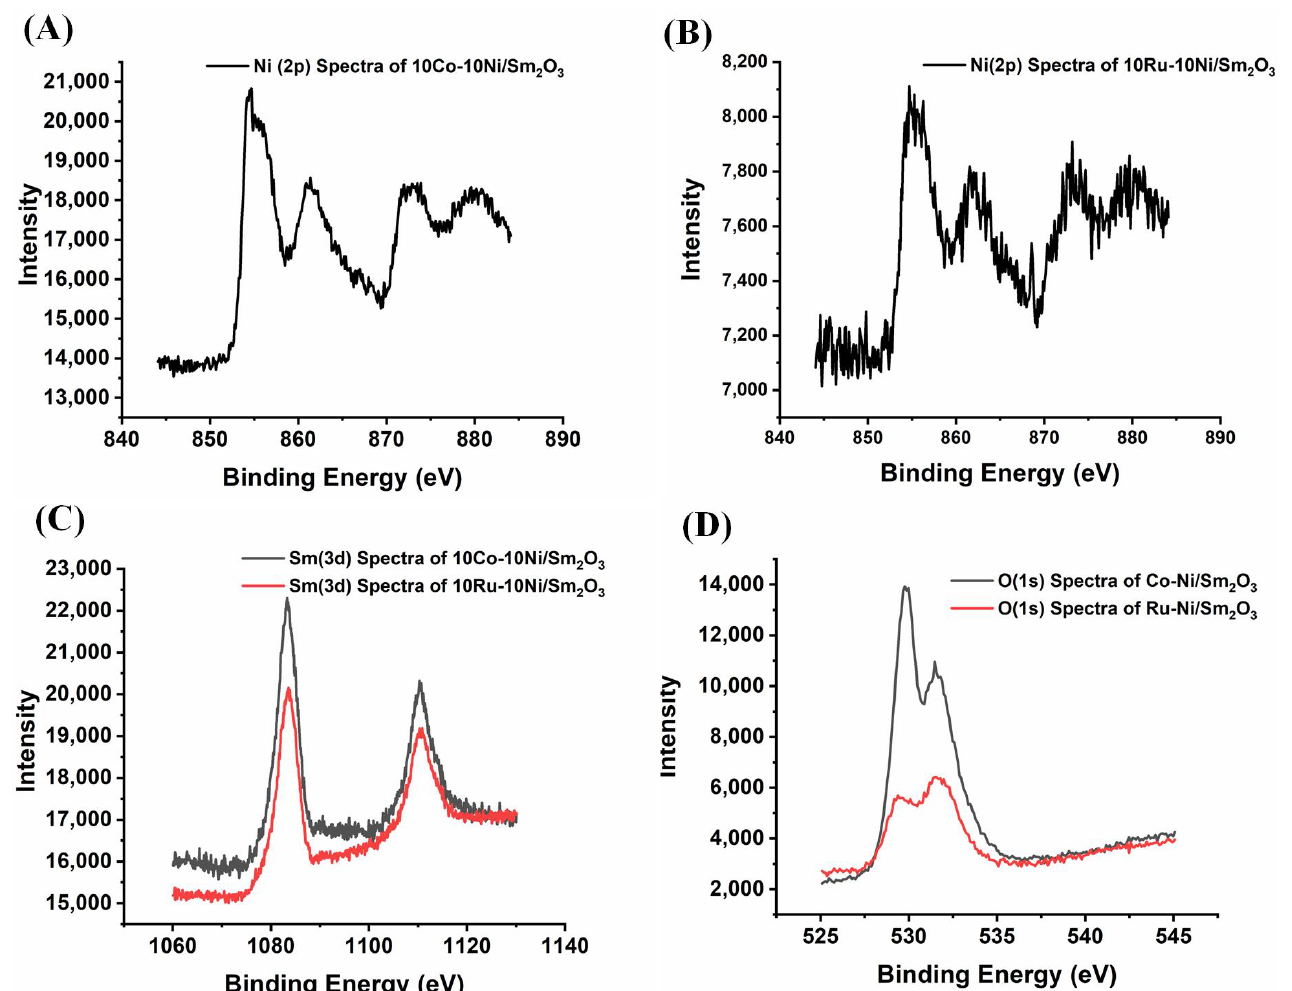
Figure 4. ( A ) Ni (2p) core-level XPS spectrum of Co-Ni/Sm 2 O 3 ( B ) Ni (2p) core-level XPS spectrum of Ru-Ni/Sm 2 O 3 catalyst ( C ) Sm (3d) XPS spectra of Co-Ni/Sm 2 O 3 and Ru-Ni/Sm 2 O 3 catalyst ( D ) O (1s) core-level XPS spectra of Co-Ni/Sm 2 O 3 and Ru-Ni/Sm 2 O 3 catalyst.